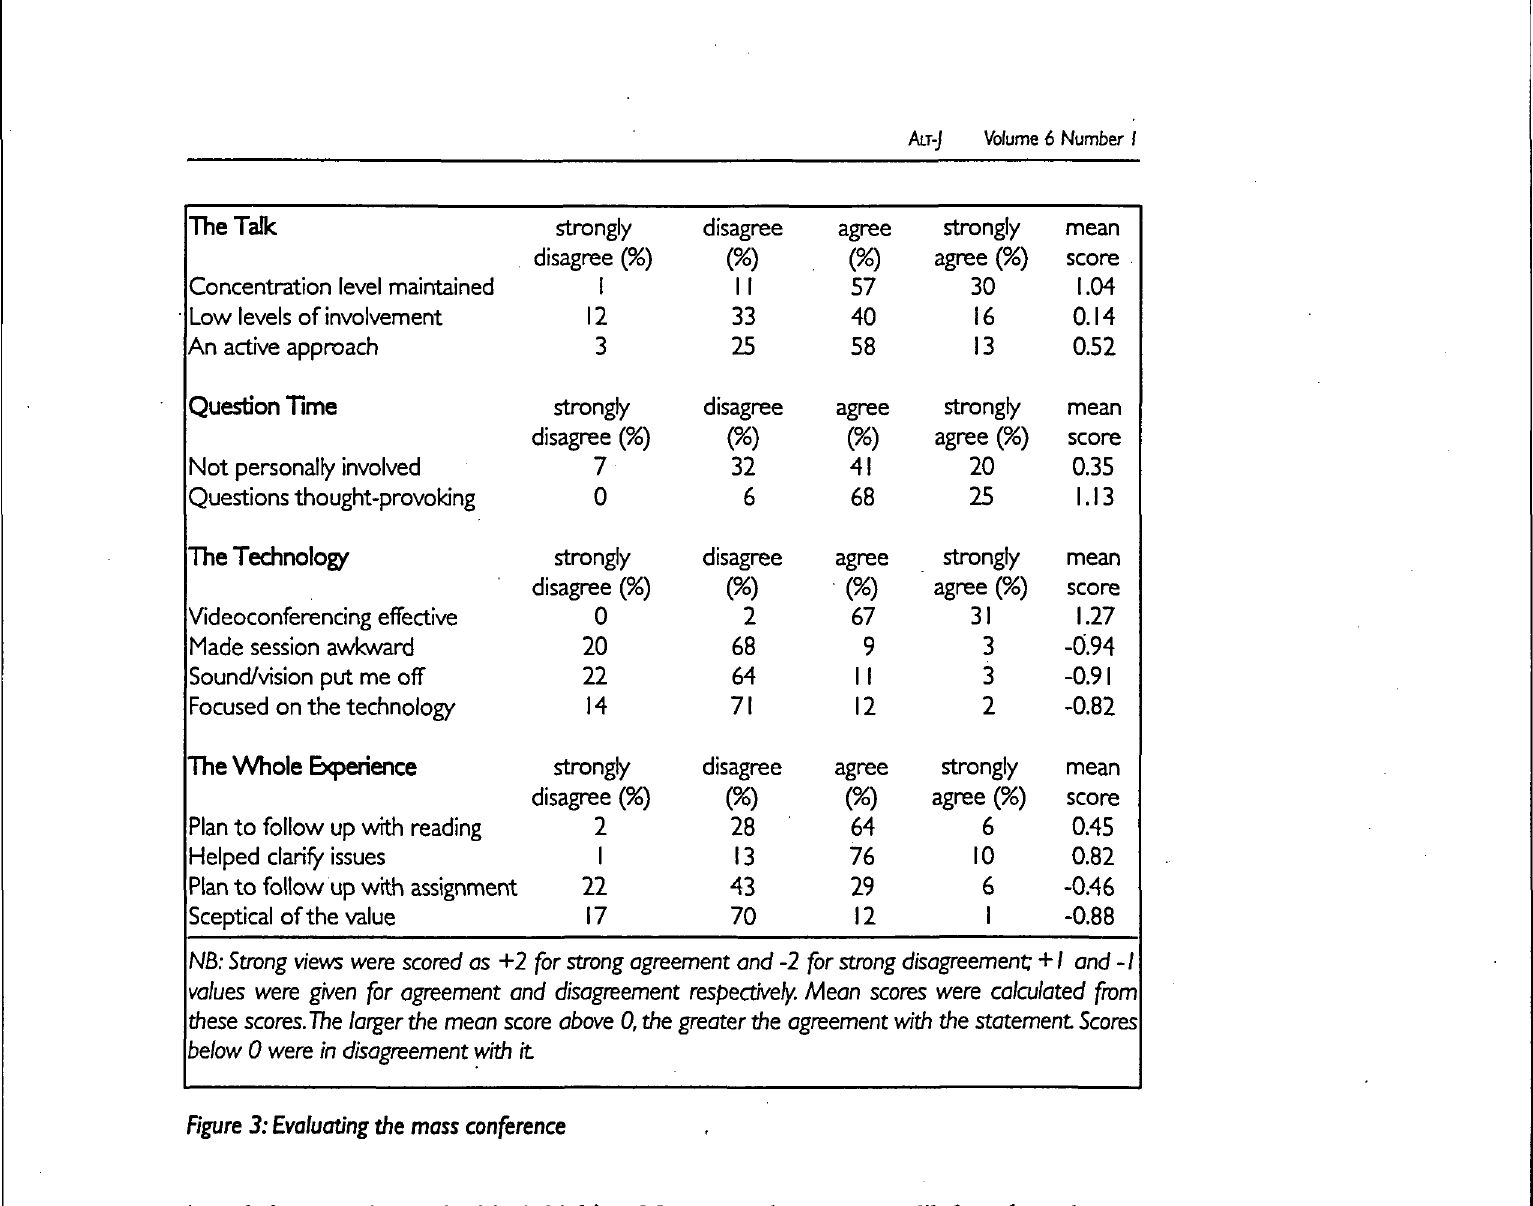
Figure 3: Evaluating the mass